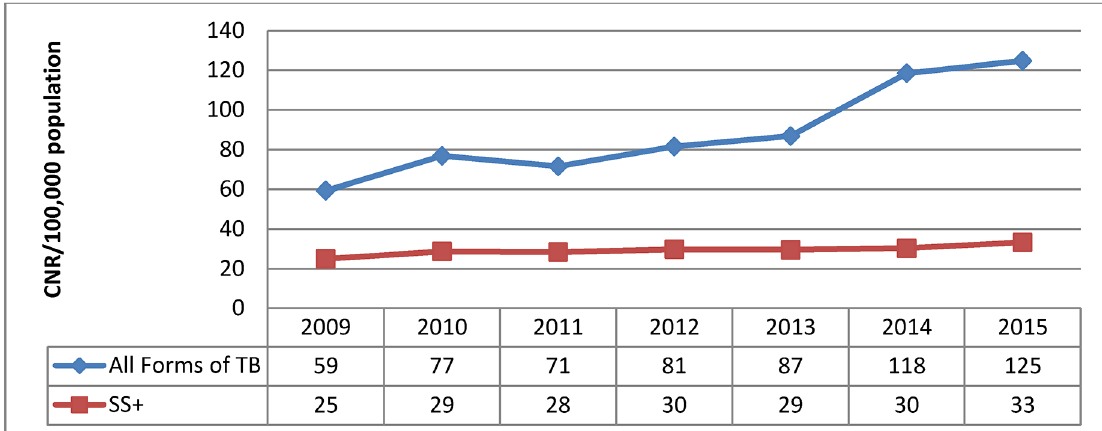
Fig 3. Case notification rate per 100,000population in Kabul, 2009–2015.